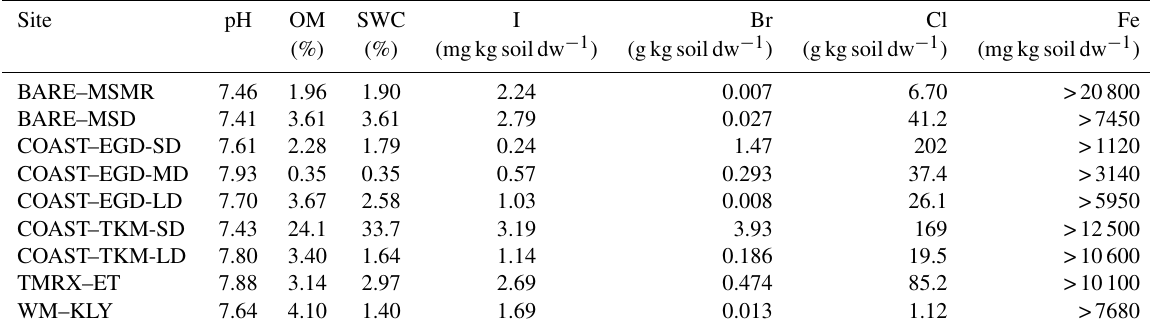
Table 3. Soil properties – OM, soil water content (SWC), I, Br, Cl and Fe fraction of dry weight and pH. Analyses were performed for a single mixture of samples at each site. See Table 1 for measurement site